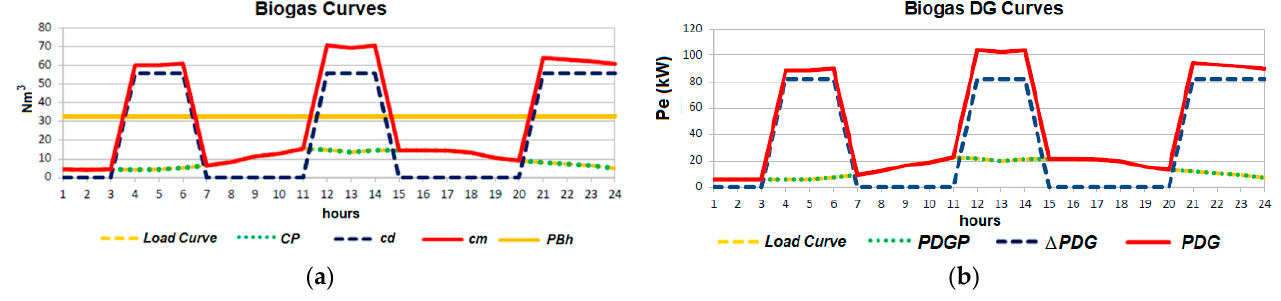
Figure 15. Case 6: ( a ) Biogas curves; ( b ) MOR from biogas DG.